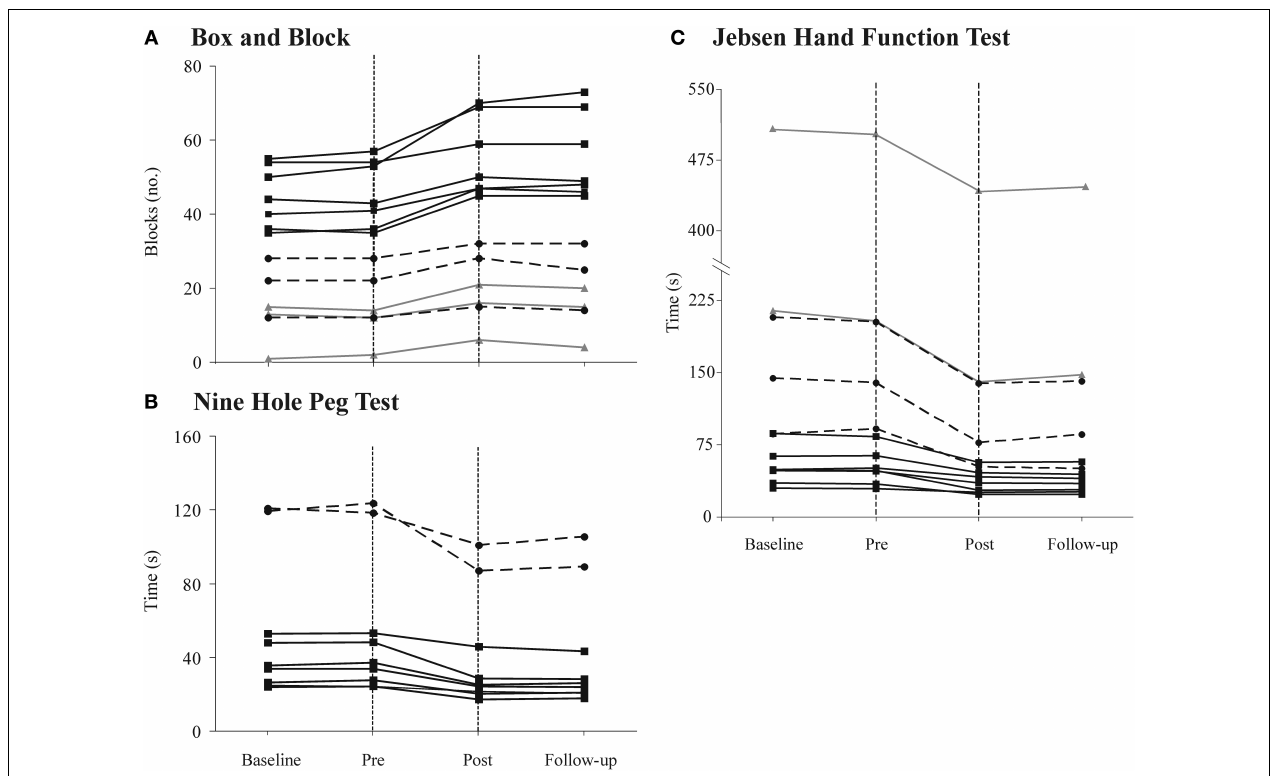
post-intervention, and follow-up.The area between the vertical doted lines represents the 3-week intervention period. In (C) , the y -axis is discontinued for a better overview of results. Note that four participants could not complete the NHPT and one could not complete the Jebsen (see text for more